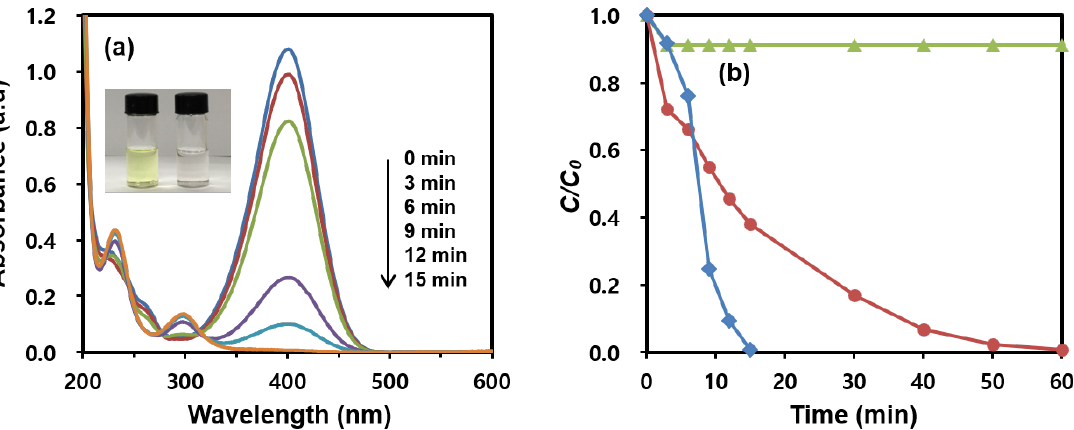
Figure 5. ( a ) Time-dependent UV-vis absorption spectral change in the 4-NPh reduction in the presence of MNP@PD 60 /Au/IO. Inset of ( a ) shows the color changes in the 4-NPh solution before ( left ) and after ( right ) the reduction. ( b ) Catalytic reduction rates of 4-NPh to 4-APh by MNP@PD 60 /Au/IO (red line), MNP@PD 60 /Au (blue line) and MNP@PD 60 /IO (green line).